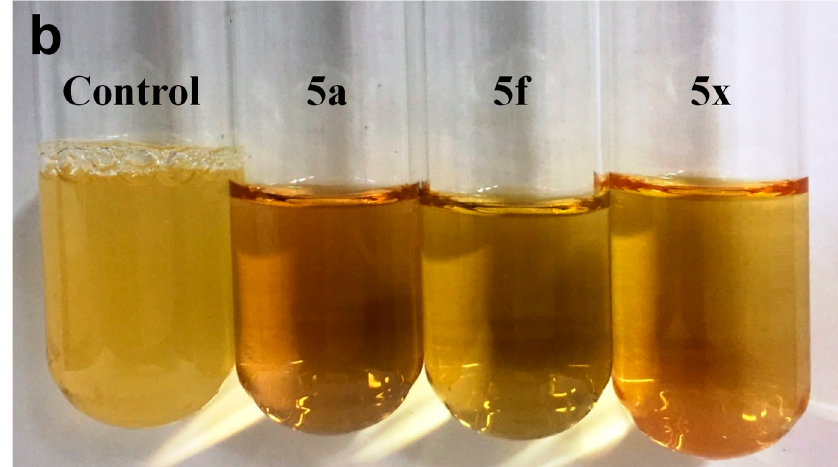
Figure 3. (a ) Time-dependent bactericidal activity of compounds 5a , 5f and 5x to E. coli . All the experiments performed in triplicates and are given the mean ± standard deviation of colony-forming units per milliliter (S.D of CFU / mL). ( b ) Images show E. coli , after 24 h treatment with compounds 5a , 5f and 5x .